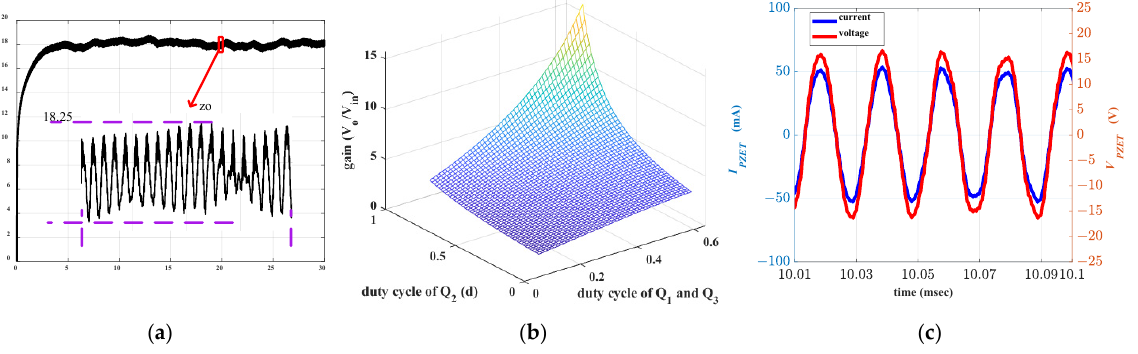
Figure 9. ( a ) Voltage response of the studied step-up DC-DC converter, which shows fast transients, high gain, and low ripple of the DC-link voltage in a simulation study. ( b ) Gain variations of the proposed DC-DC power converter against simultaneous changes of the switches’ duty cycles in a simulation study. ( c ) PZET current and voltage waveforms in the